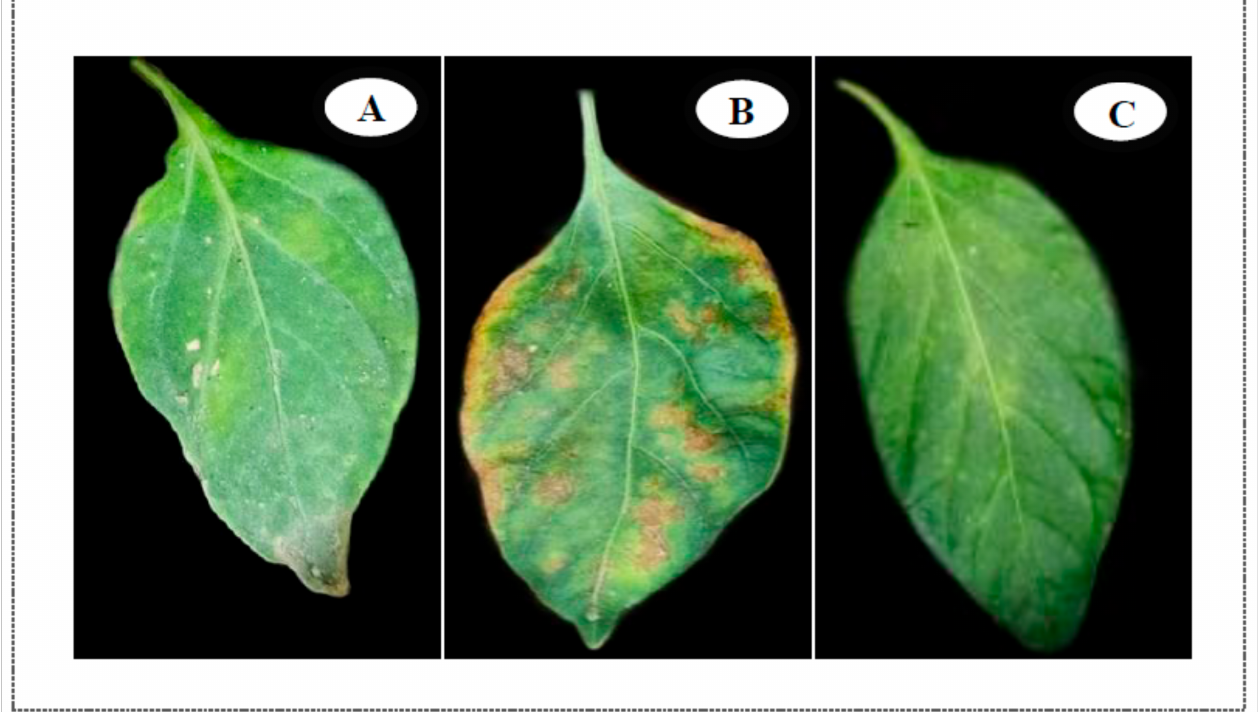
Figure 4. Sweet pepper plant leaves with inoculation and treatments of SiO 2 -NPs and BCA. ( A ) Control, ( B ) Artificial inoculation symptoms caused by Xanthomonas vesicatoria , ( C ) Suppression of pepper bacterial leaf spot disease after treatments with (150 ppm SiO 2 -NPs and 5%